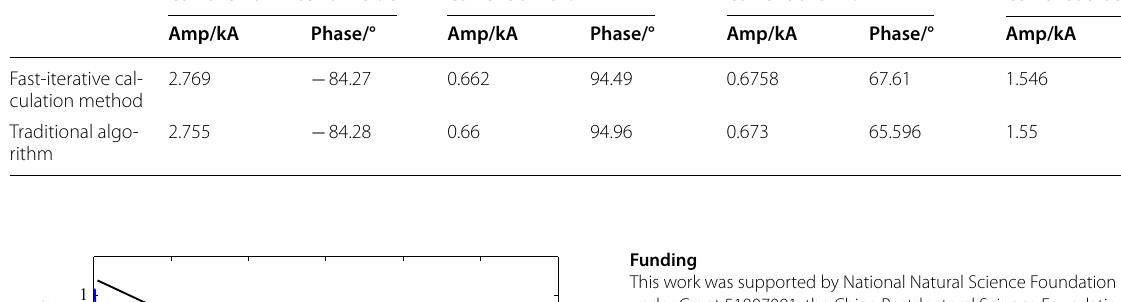
Table 6 Comparison of the fast‑iterative calculation method with the conventional algorithm under a three‑phase fault at point f Current from